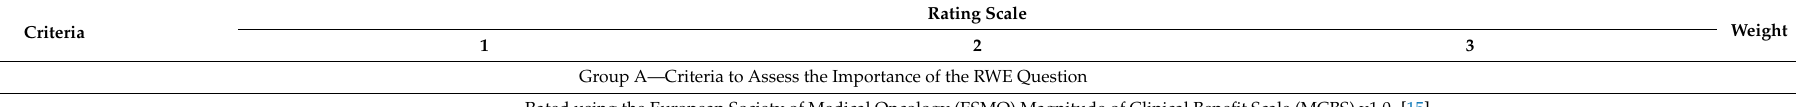
Table 2. Current MCDA Rating